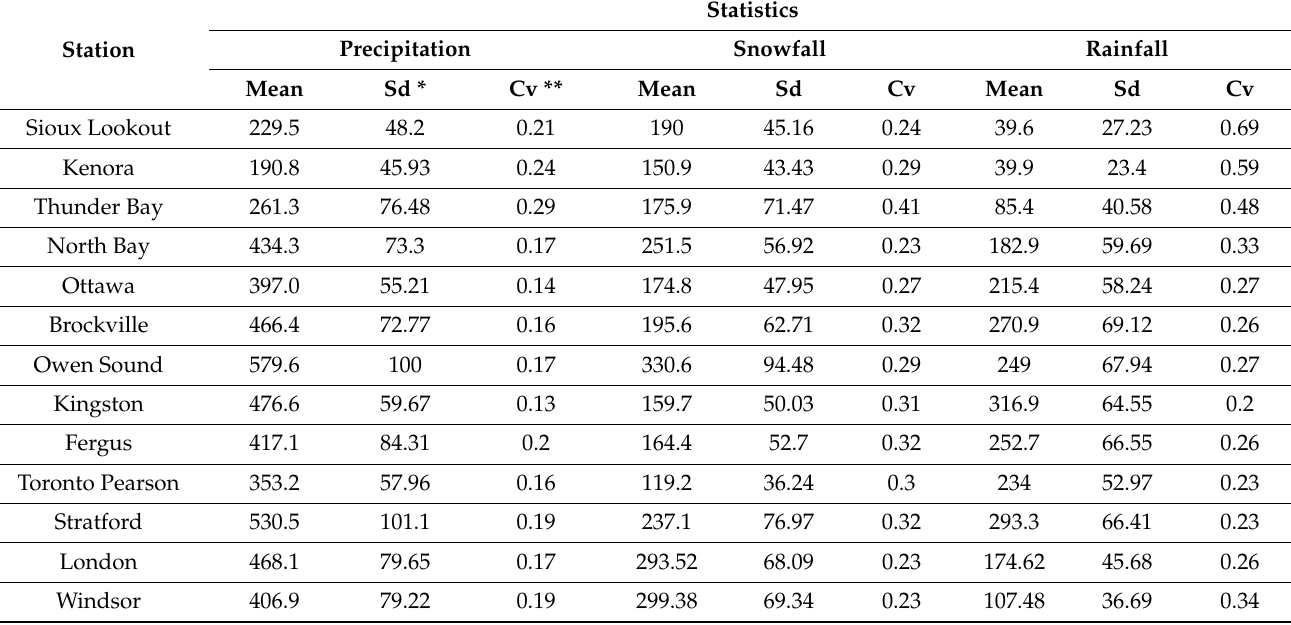
Table 3. Variability and central tendency of winter